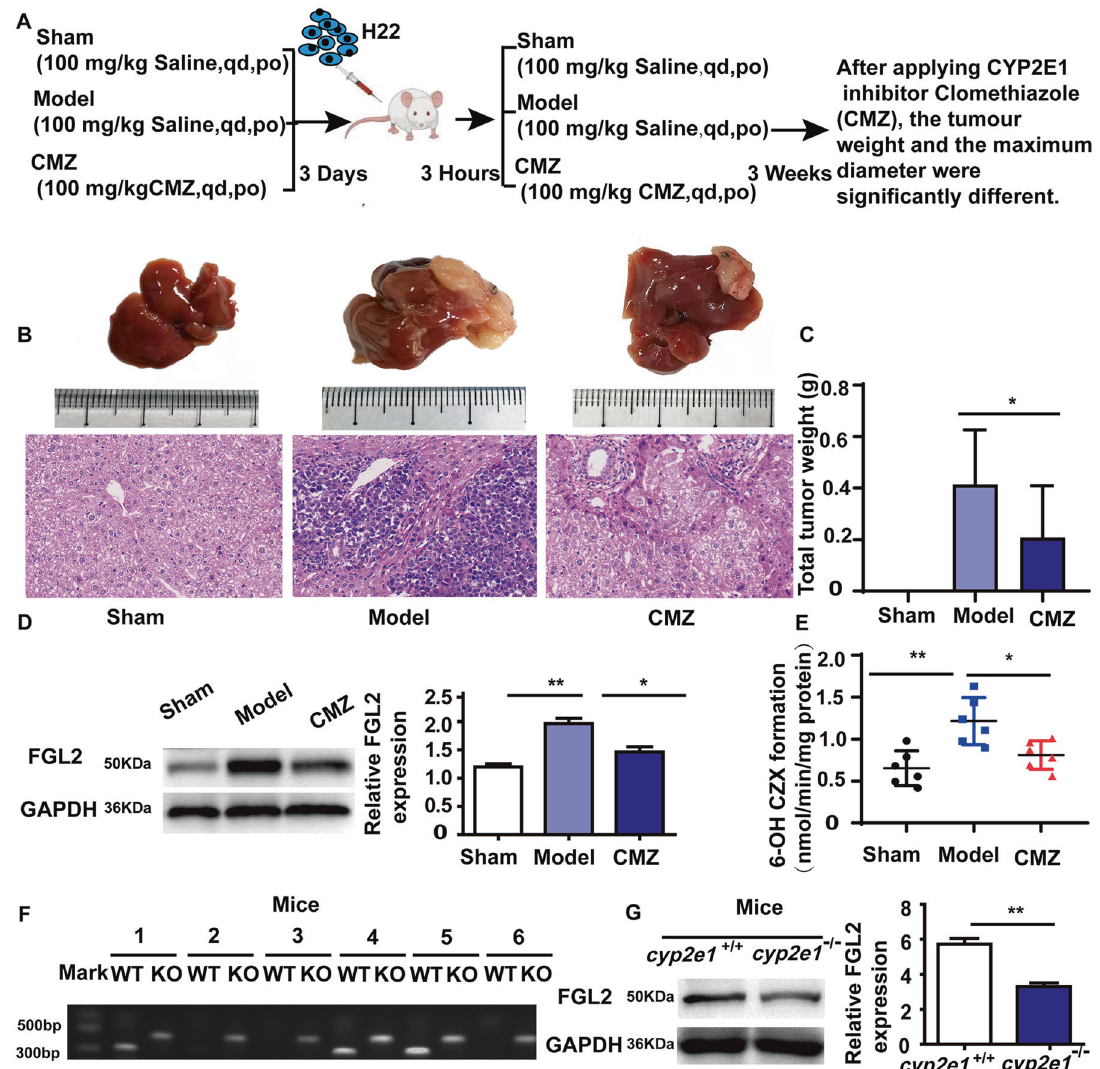
Fig. 6 CYP2E1 regulates STAT4-mediated FGL2 expression. A Experimental scheme of the effect of CMZ on FGL2 in BALB/c mice. B Representative images of macroscopic liver (top) and H&E staining (bottom) (scale bar, 50 µm). C The tumor weight; sham group ( N = 10), model group ( N = 12), CMZ group ( N = 12), *P < 0.05, **P < 0.01 was assessed by one-way ANOVA. D The expression of FGL2 in liver tissues in an orthotopic transplantation tumor model of H22 cells in BALB/c mice by western blot ( N = 3). E The 6-hydroxy-CZX formation ( N = 6), *P < 0.05 and **P < 0.01 was assessed by one-way ANOVA. F The effect of cyp2e1 knockout in mice was identi fi ed by PCR. Mice no. 1, no. 2, no. 3, and no. 5 only showed bands around 520 bp, and no bands around 464 bp, which were mutant homozygous ( N = 6). Mice no. 4 and no.